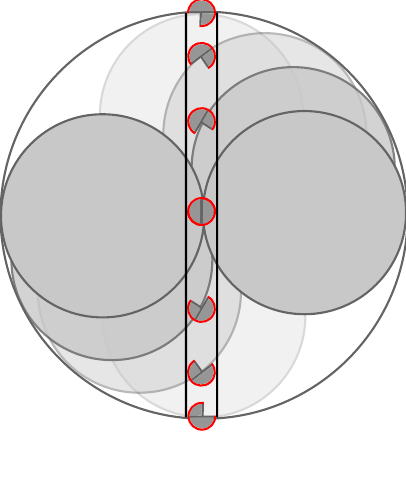
Figure 4. Schematic representation of the motion of the supports in between the leaf springs. Contact with both leaf springs is always ensured, because of the pin shape (shown in